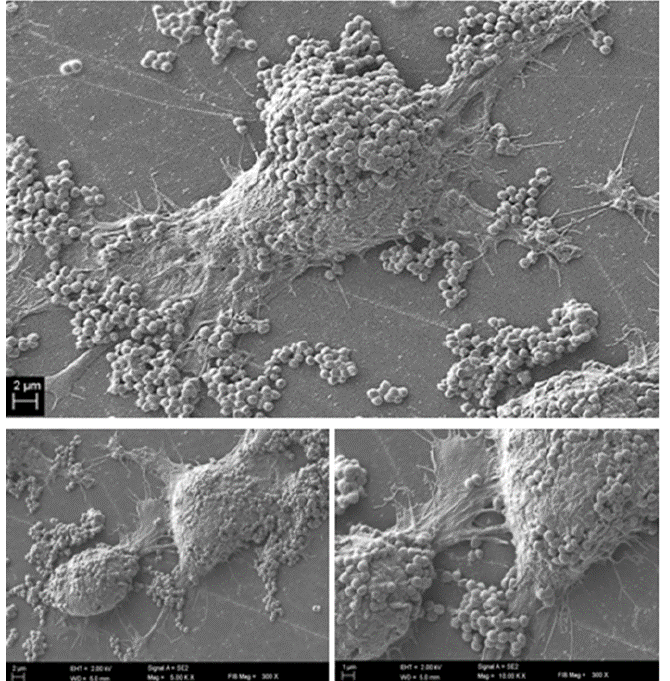
Figure 5 . Co-culture of fibroblast ad staphylococci 12 h post contamination—reflecting critical colonization stage of infection. Magnification 5000, and 10,000×, respectively.